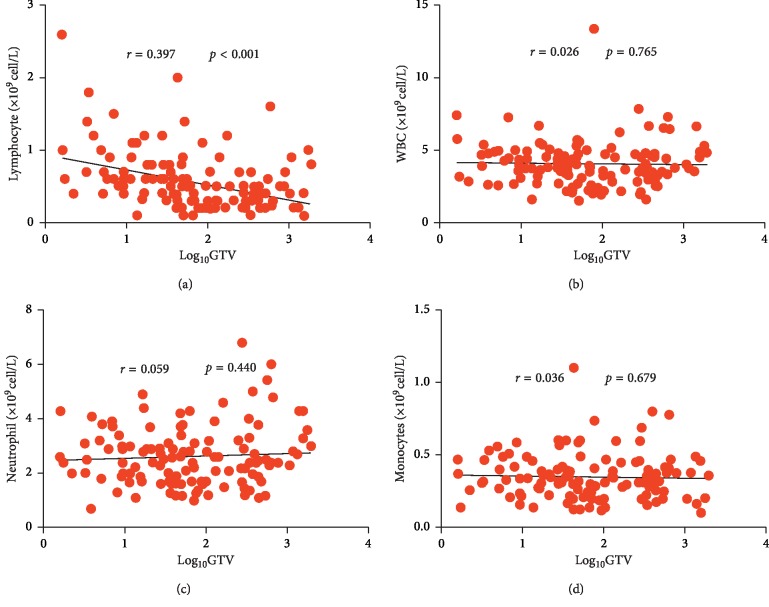
Correlations among lymphocyte (a), WBC (b), neutrophil (c), and monocyte nadir (d) (×109 cell/L) during RT with log10GTV in patients with HCC.